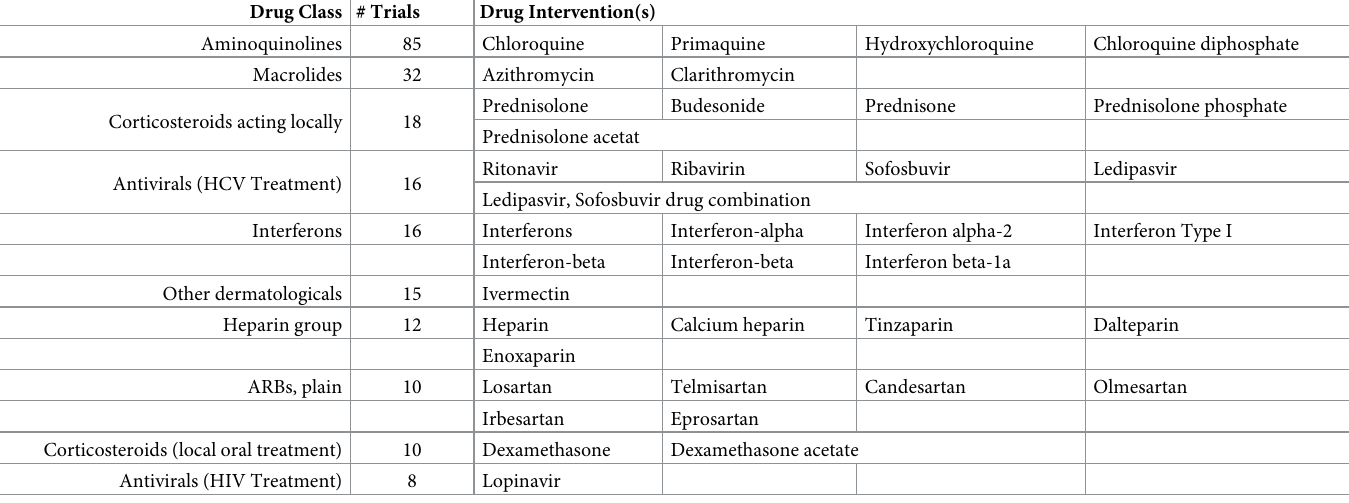
Table 4. Top 10 drug classes, the number of clinical trials with interventions in each class and the interventions belonging to the class. Drug Class #